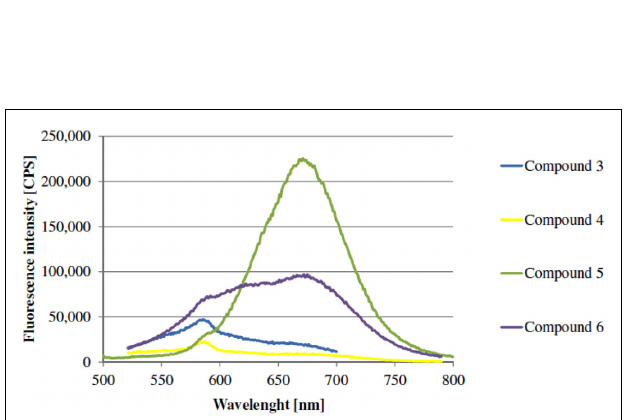
FIGUREA3 | Fluorescence emission spectra of chalcone derivatives with O -alkyl-ether as spacer B (Excitation wavelength: 405nm).